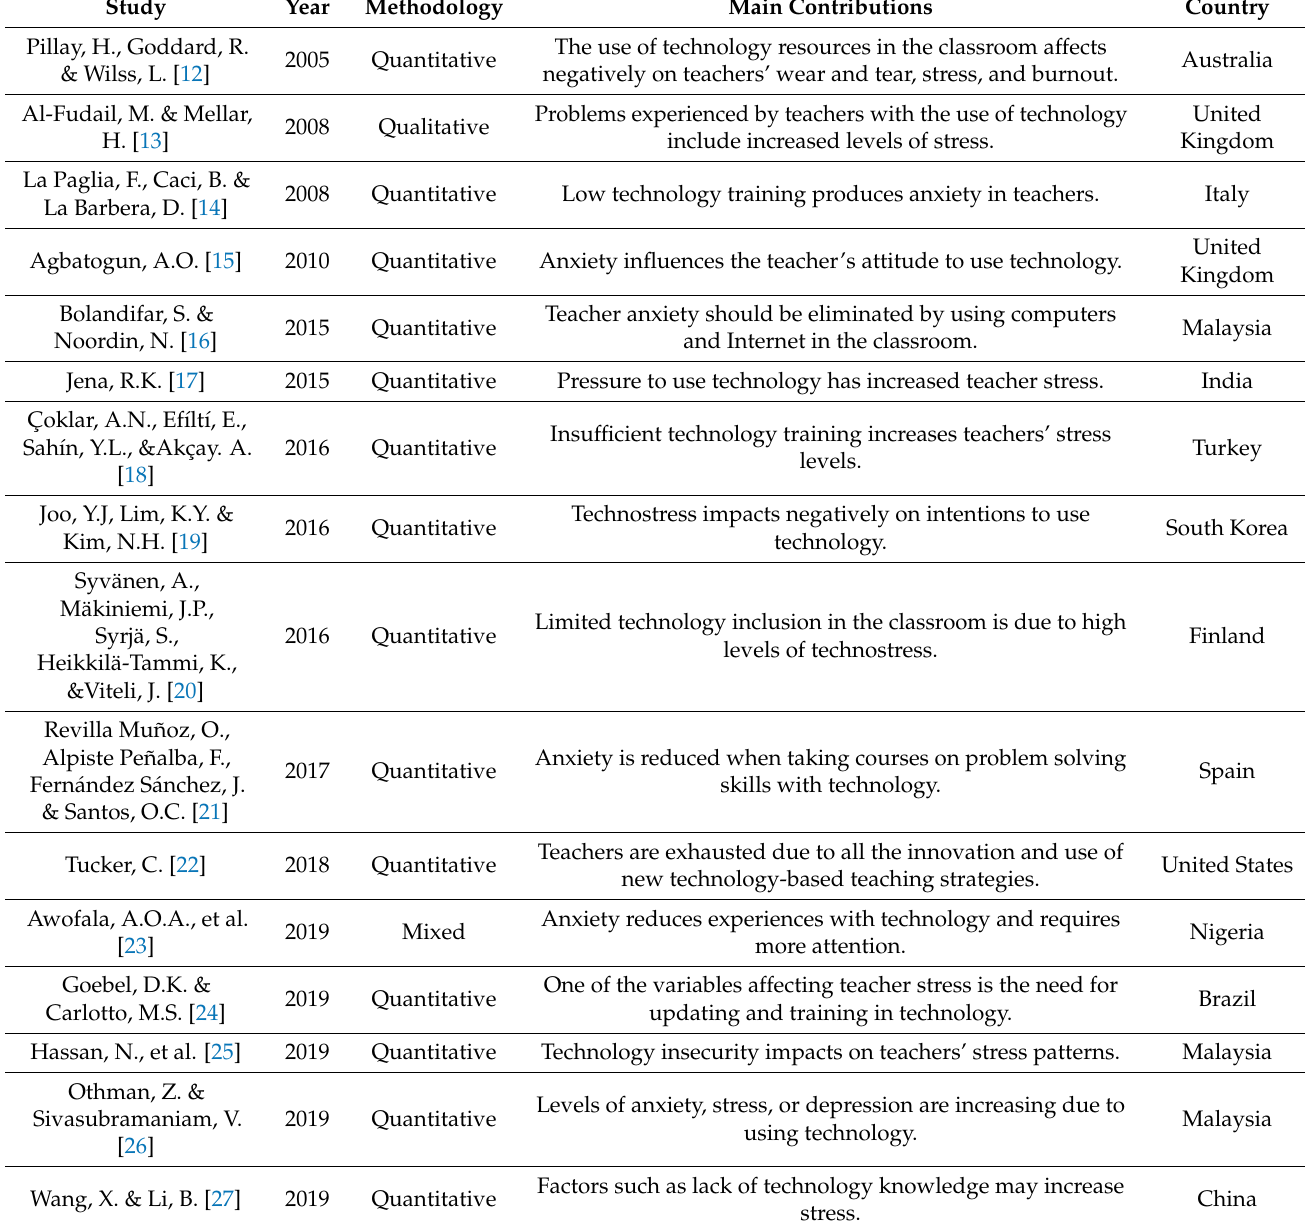
Table 1. Analysis of selected